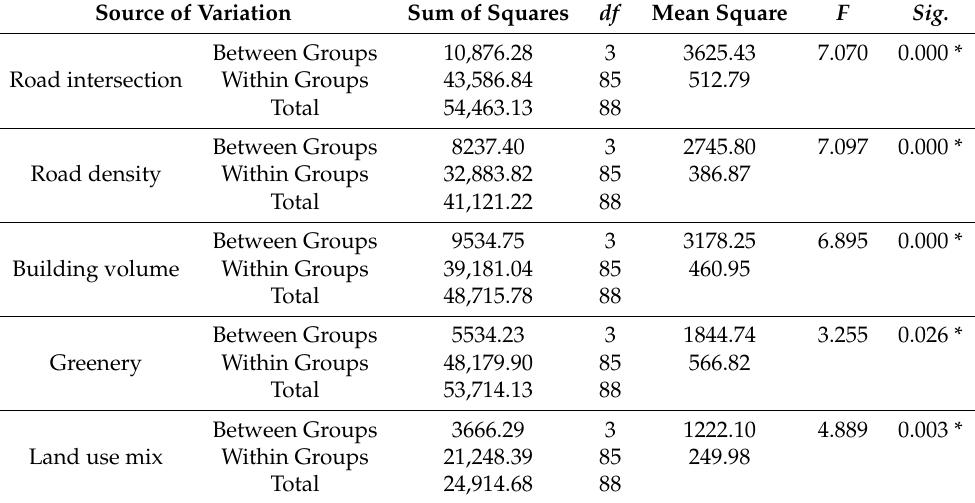
Table 2. Results of one-way analysis of variance (ANOVA) on mean normalized scores. Source of Variation Sum of Squares df Mean Square F Sig. Between Road intersection